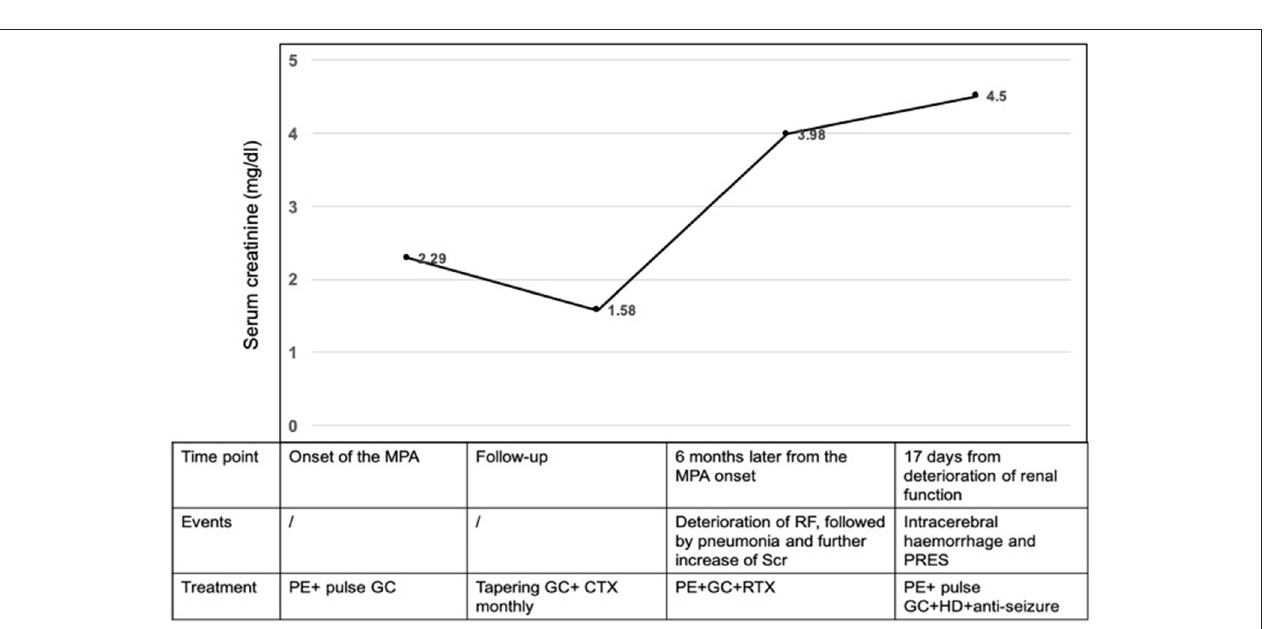
FIGURE 3 | Clinical findings timeline. MPA, microscopic polyangiitis; GC, glucocorticoid; CTX, cyclophosphamide; PE, plasmapheresis; RTX, rituximab; RF, renal function; PRES, posterior reversible encephalopathy syndrome; HD,